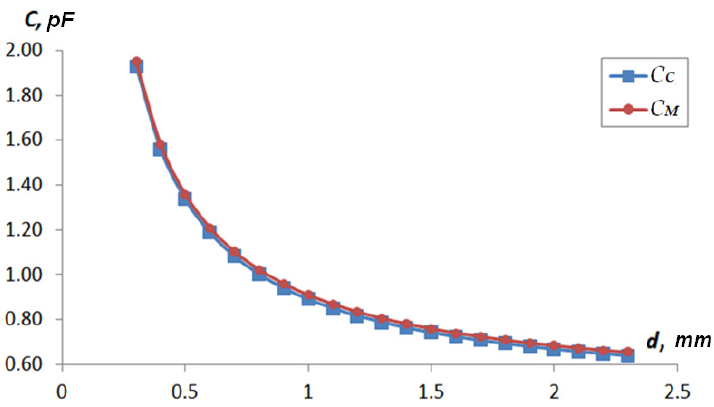
Figure 12. Type 2 sensor response function depending on the distance to the shaft surface.